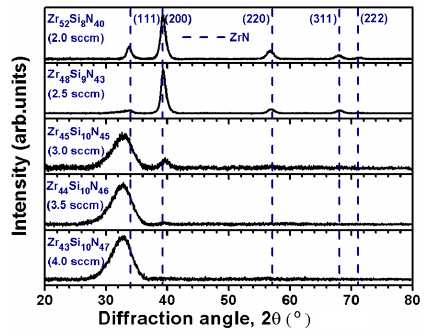
Figure 3. Grazing ‐ incident X ‐ ray diffraction (GIXRD) patterns of Zr–Si–N films fabricated using various nitrogen flow rates.